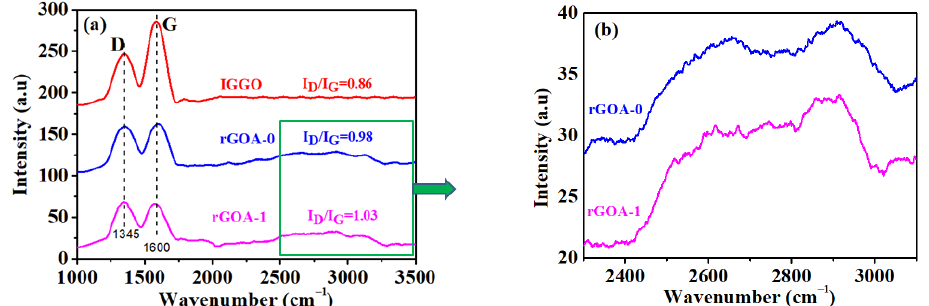
Figure 4. Raman spectra of IGGO, rGOA-0, and rGOA-1 ( a ) and up-shift 2D peaks in Roman spectra of rGOA-0, and rGOA-1( b ).